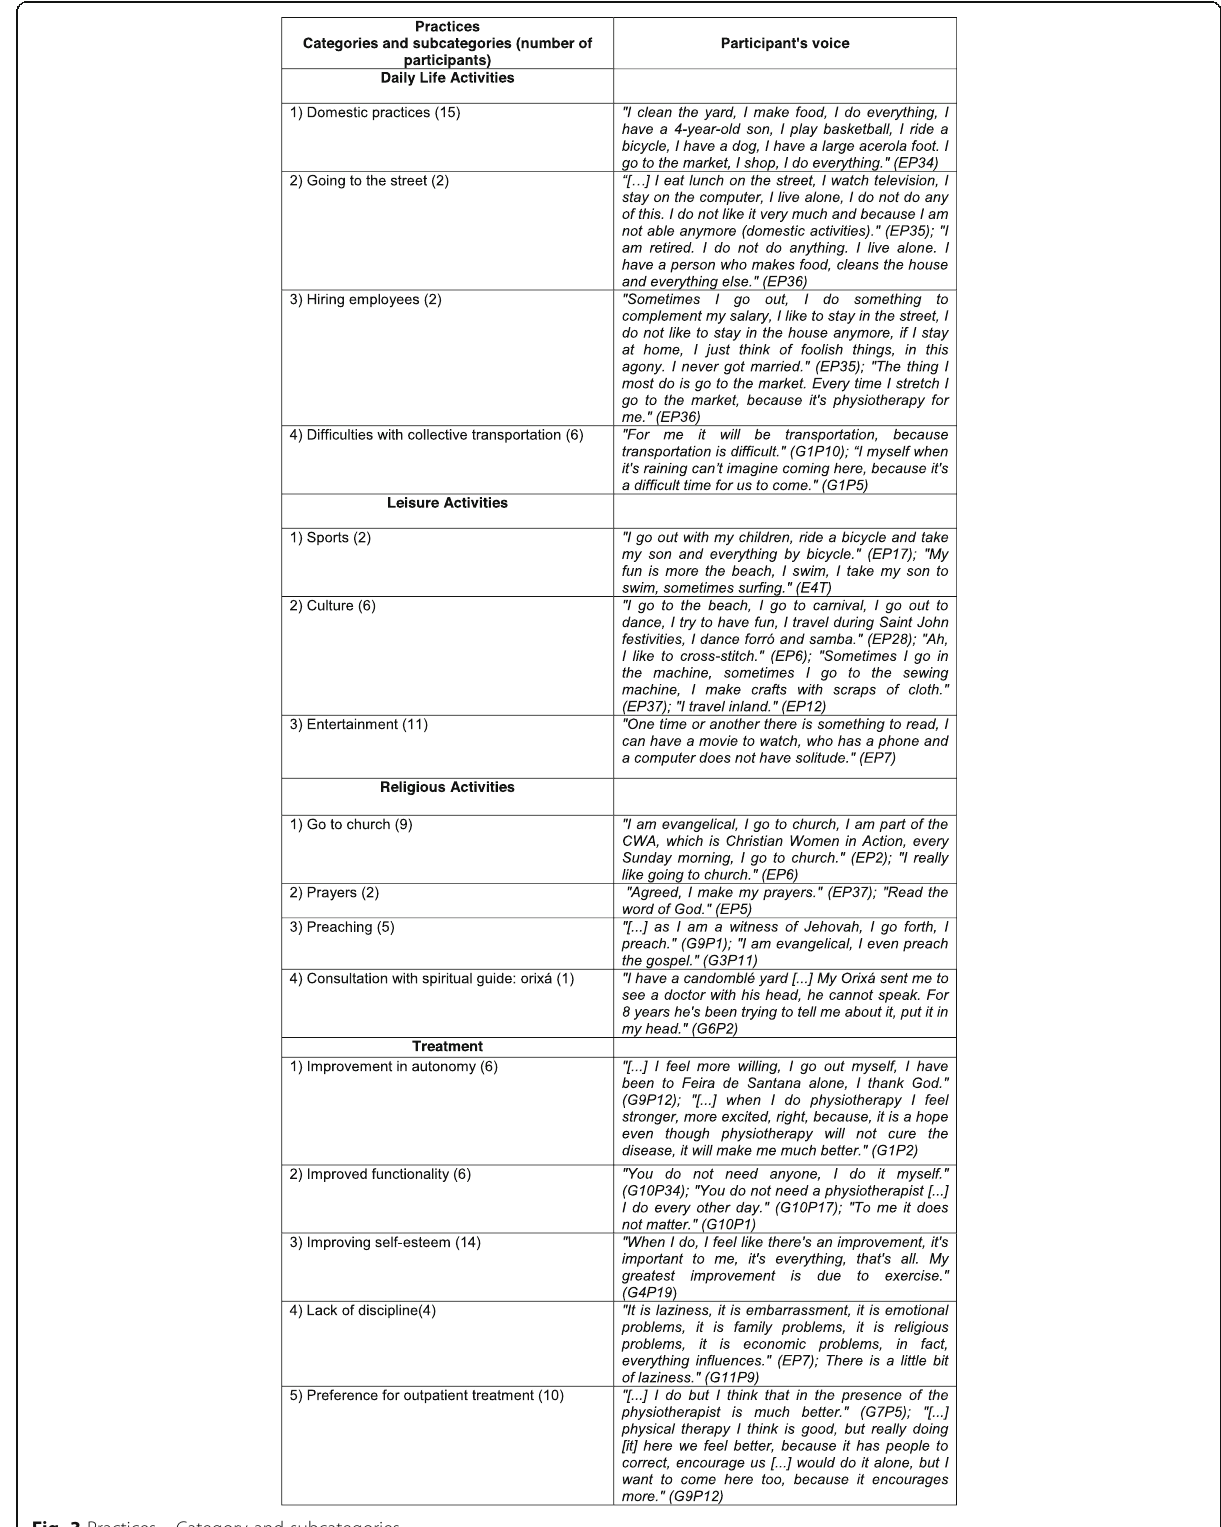
Fig. 3 Practices — Category and